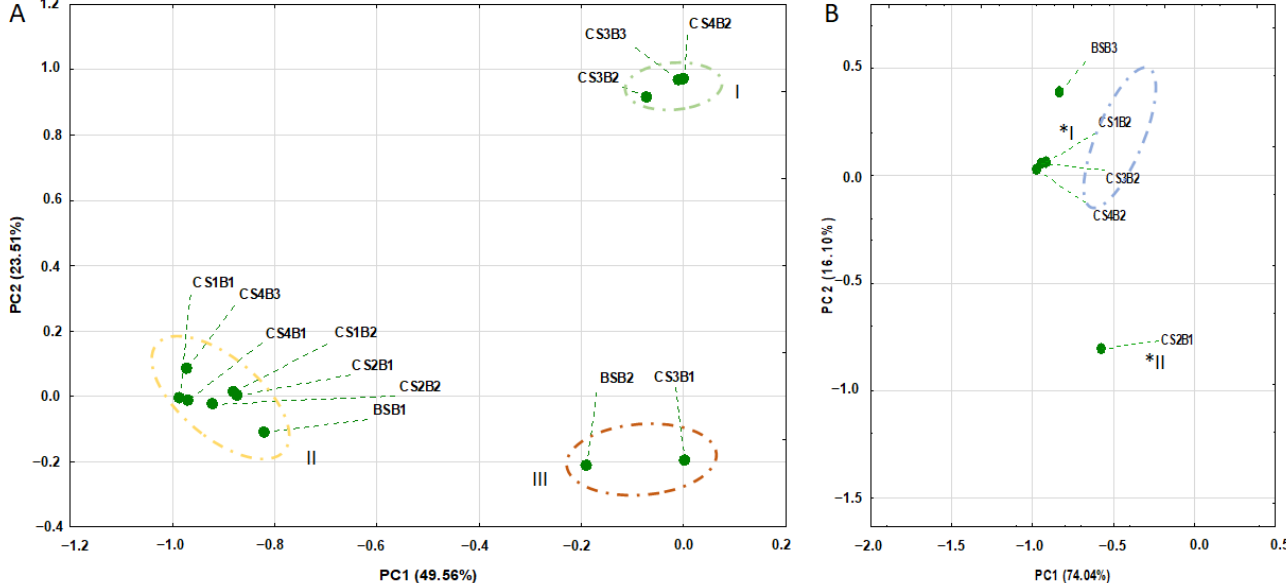
Figure 1. Principal component analysis of ( A ) non-volatile compounds and ( B ) volatile compounds.